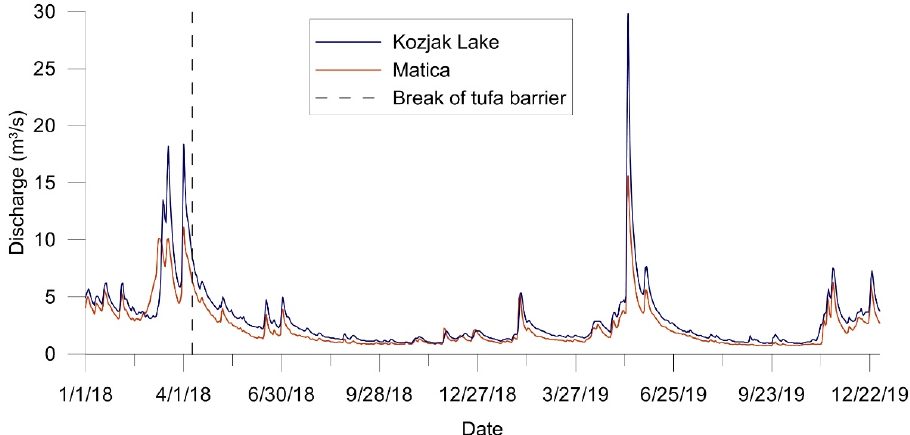
Figure 15. Course of the oscillating mean annual discharges at the Kozjak Lake and Matica stations, marking the period during which the breaking ‐ off of the Milino Lake barrier was observed.